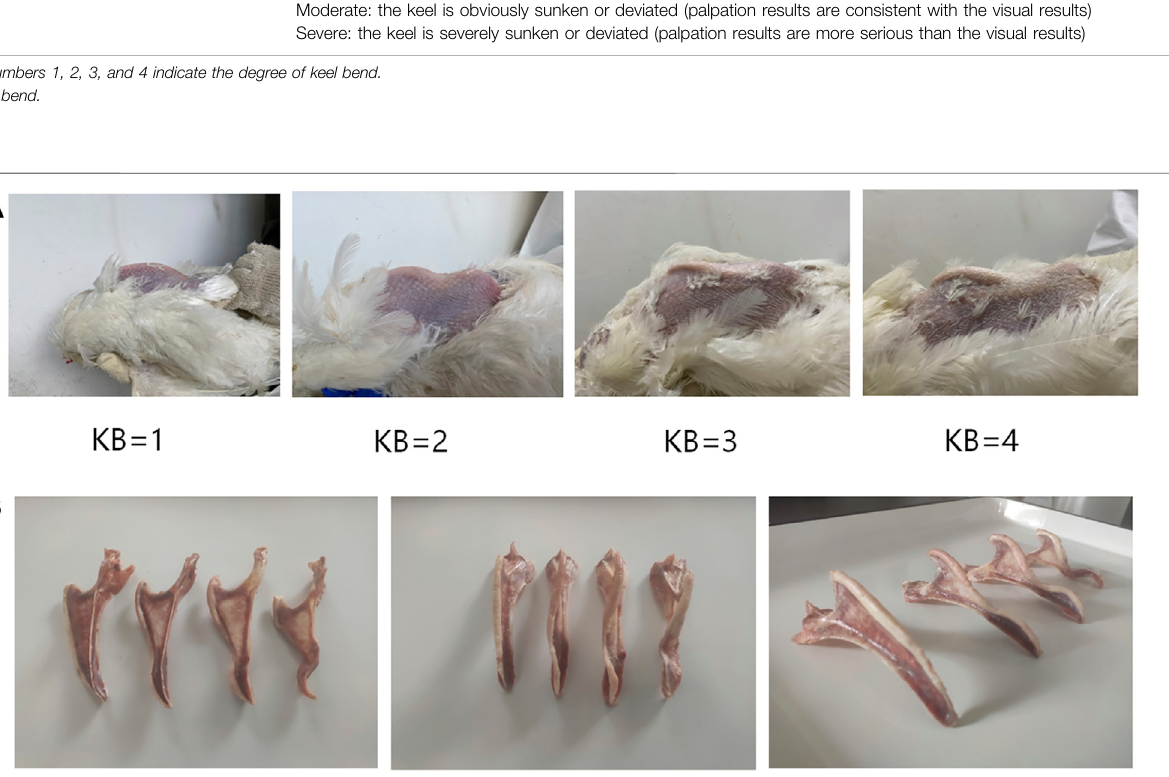
Table 1 . In summary, KBs can be categorized into one of four levels according to the degree of the bend: normal, slight, moderate, or severe, recorded as 1, 2, 3, and 4, respectively ( Figure 1A ). Examples of the different levels are shown in Figure 1B . To ensure consistency in assessment, only one palpator was used, and the palpator assessed 100 chickens as a training exercise prior to data gathering. These chickens were